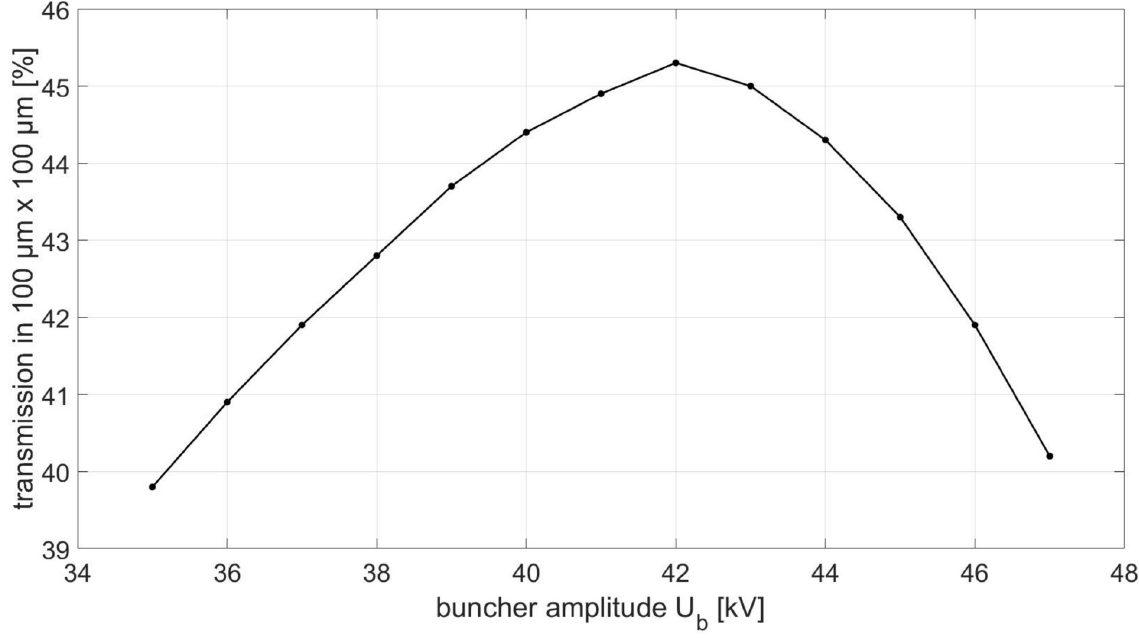
Fig 3. Proton transmission into an area of 0.1 x 0.1 mm 2 at the focus (see Fig 1) as a function of buncher amplitude U b